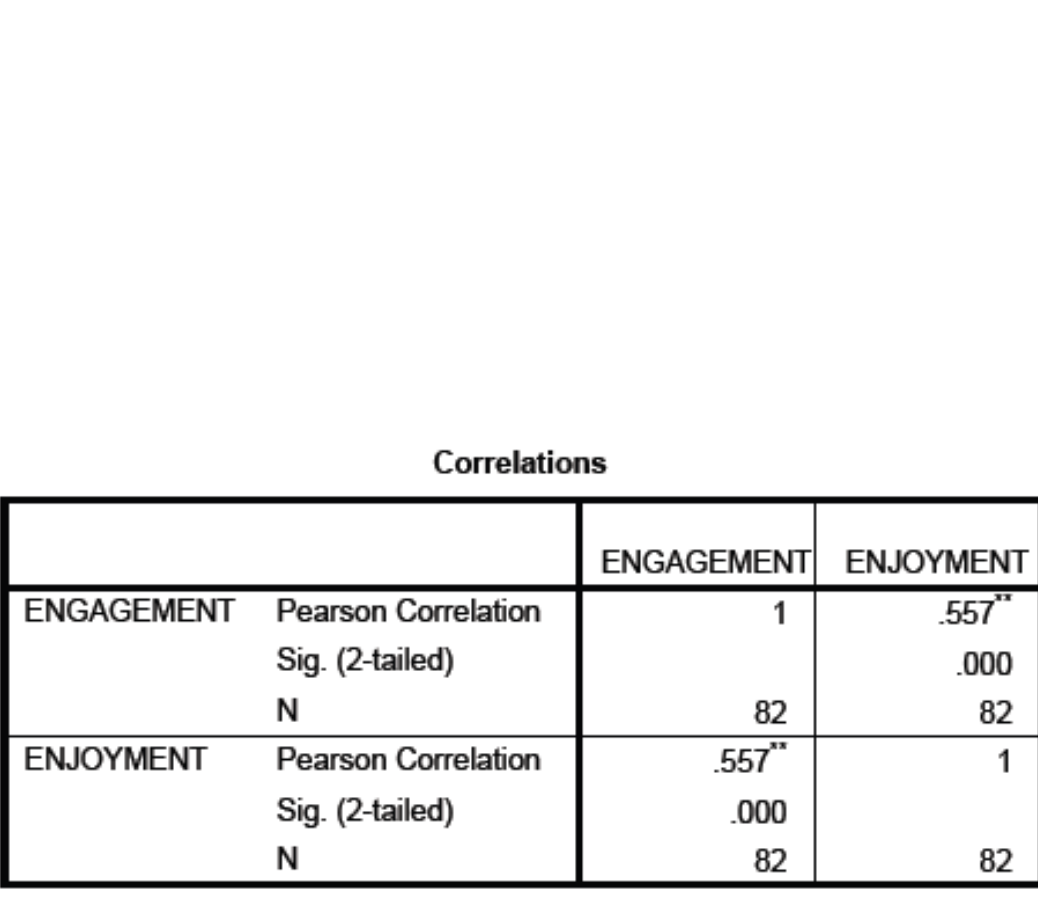
Figure B.23. Correlation between engagement and enjoyment